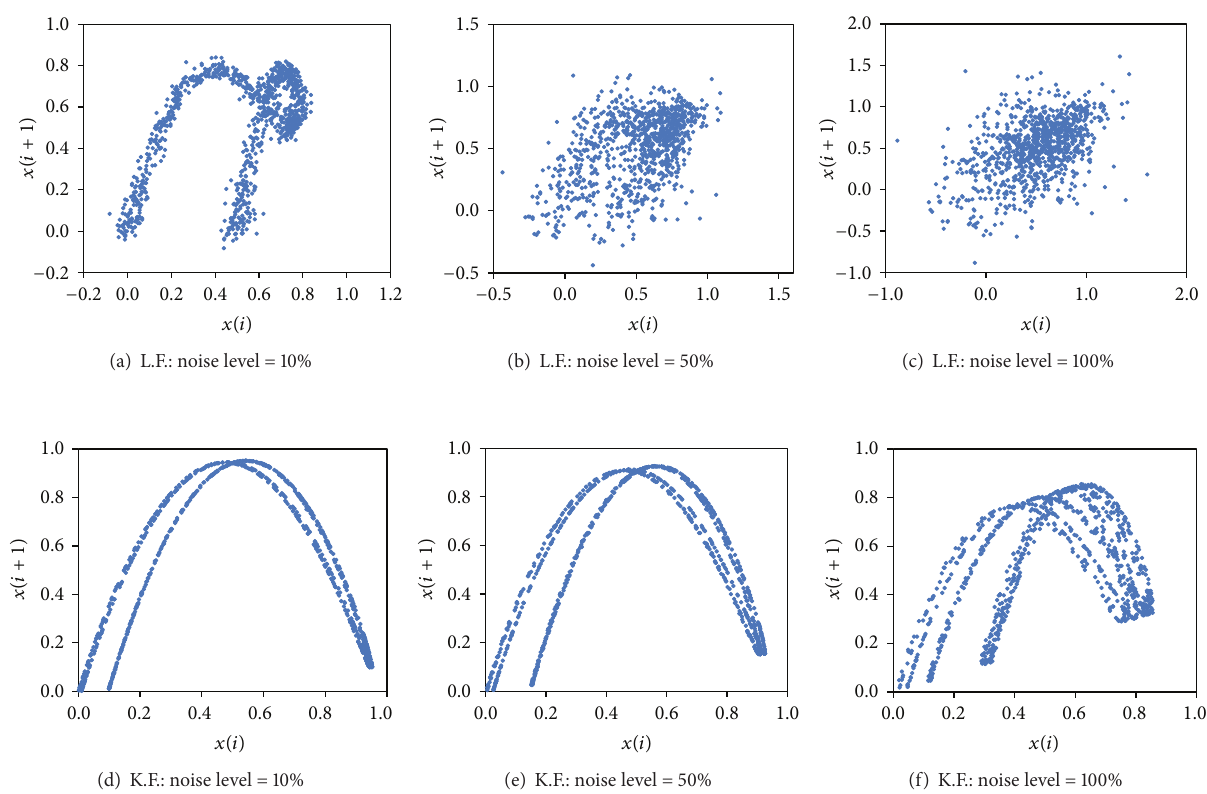
Figure 4: The noise removed attractors by LF and KF.